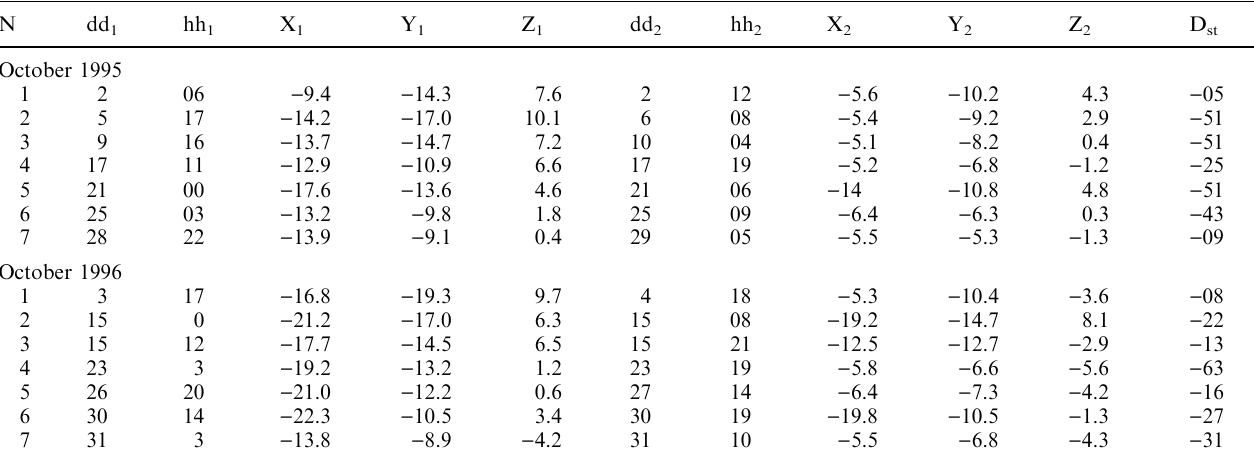
Table 1. Time intervals selected for the study. Coordinates are presented in the GSM-system in the Earth’s radii, dd is the day and hh is the hour (in UT). The indices 1 and 2 denote the values attributed to the initial and final positions of the spacecraft, respectively